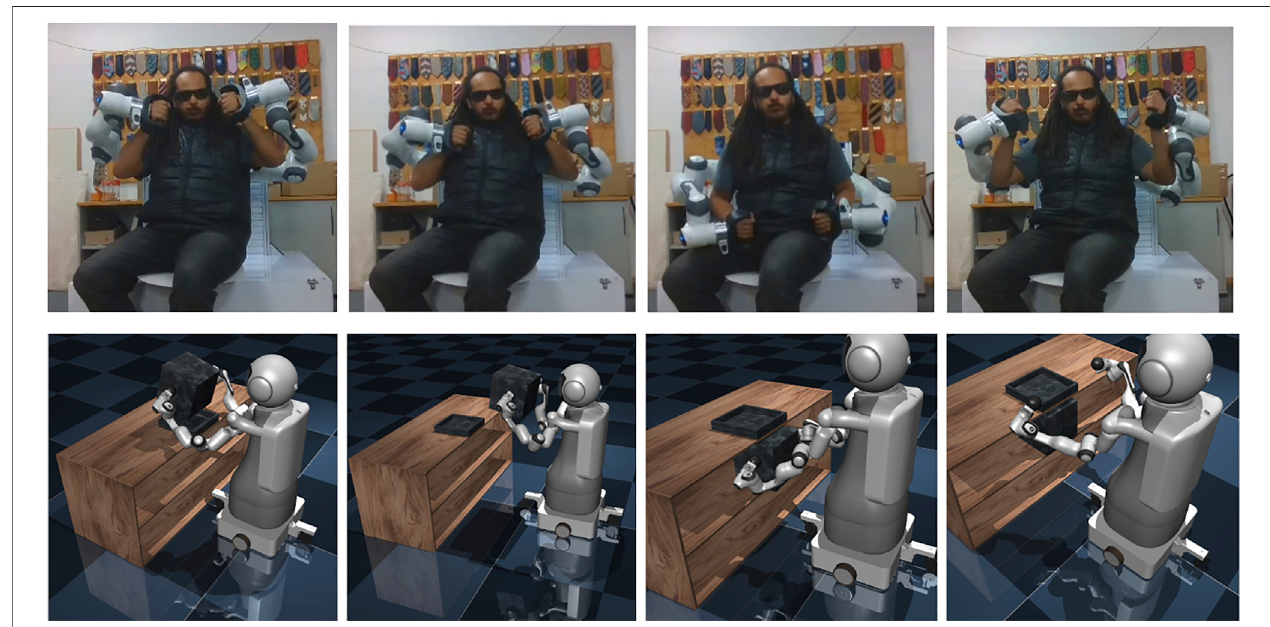
FIGURE8| VisualizedsequenceofthedigitaltwinofGARMI(bottomrow)andthecoupledrealPARTIsystem(toprow)duringthethirdexperiment.Theoperatoris tasked with lifting the box from its socket, which has a clearance of only 2 mm and putting it into the shelve below with a clearance of 2 cm.